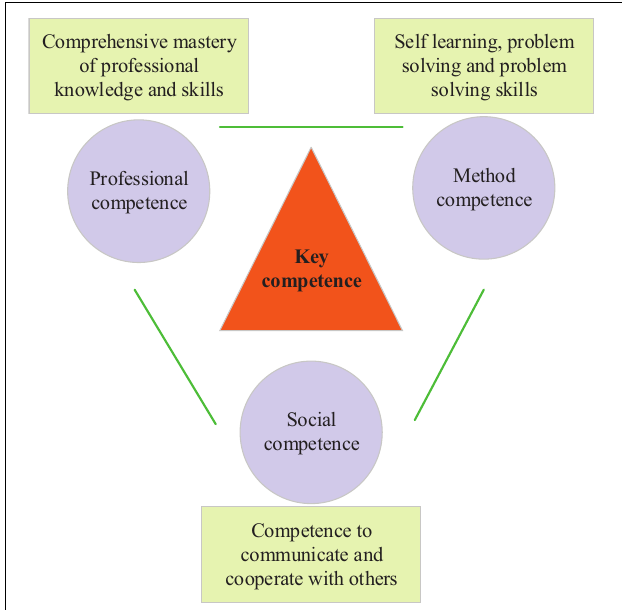
FIGURE 1 | Three elements of professional action ability based on key competence.